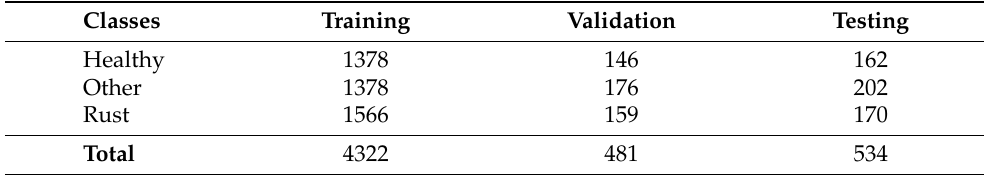
Table 3. Summary of the distribution of images in the proposed dataset.